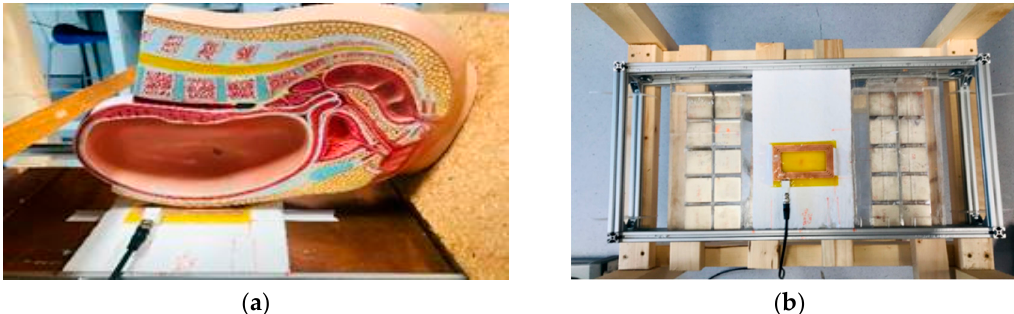
Figure 2. ( a ) Side view of the magnets and coil with a pregnancy model showing positioning and ( b )